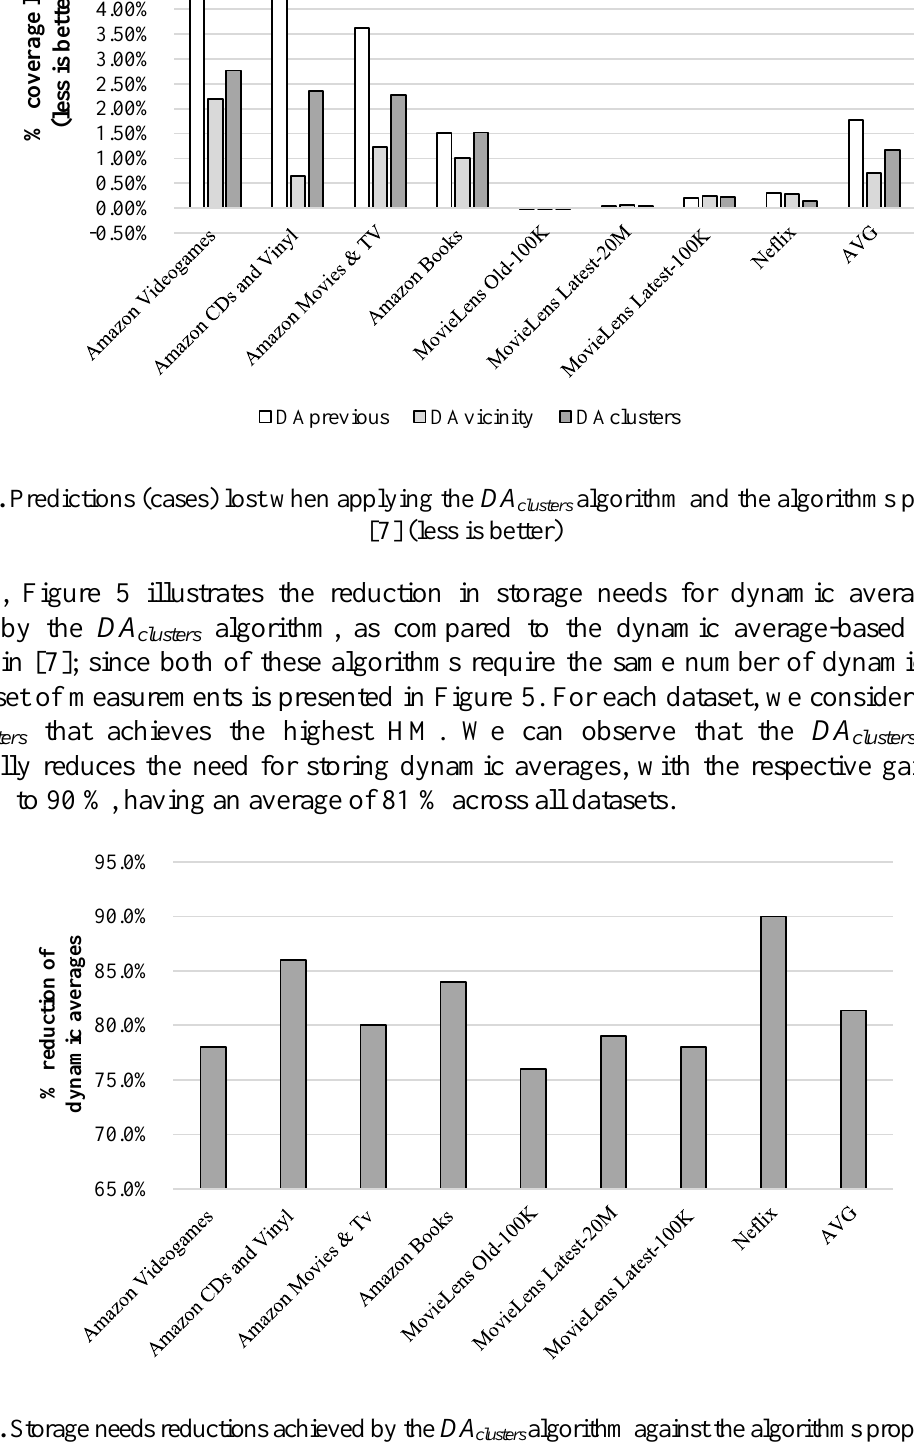
algorithm against the algorithms proposed in clusters